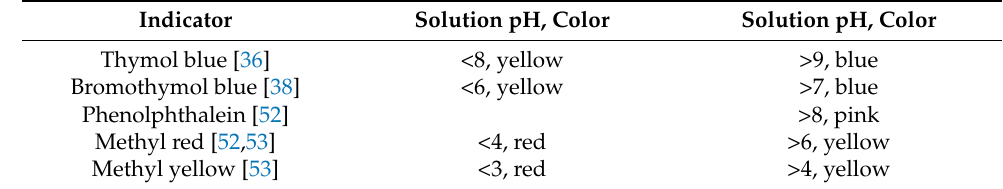
Table 1. Solution pH and colors associated with the powder indicators in this study.